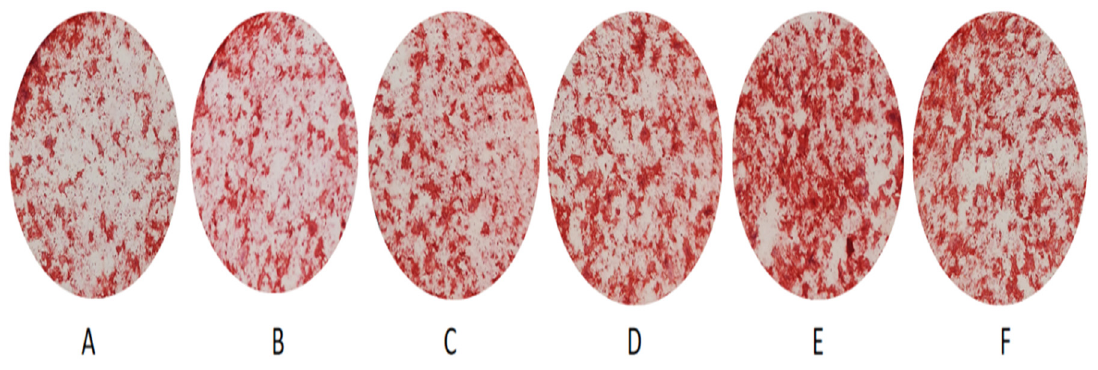
Figure 11. Alizarin red staining results after 14-day culture: ( A – F ) the control, 0, 10, 20, 30, and 40% PLGA–PEG–PLGA/C 3 S/C 2 S/POP, respectively.